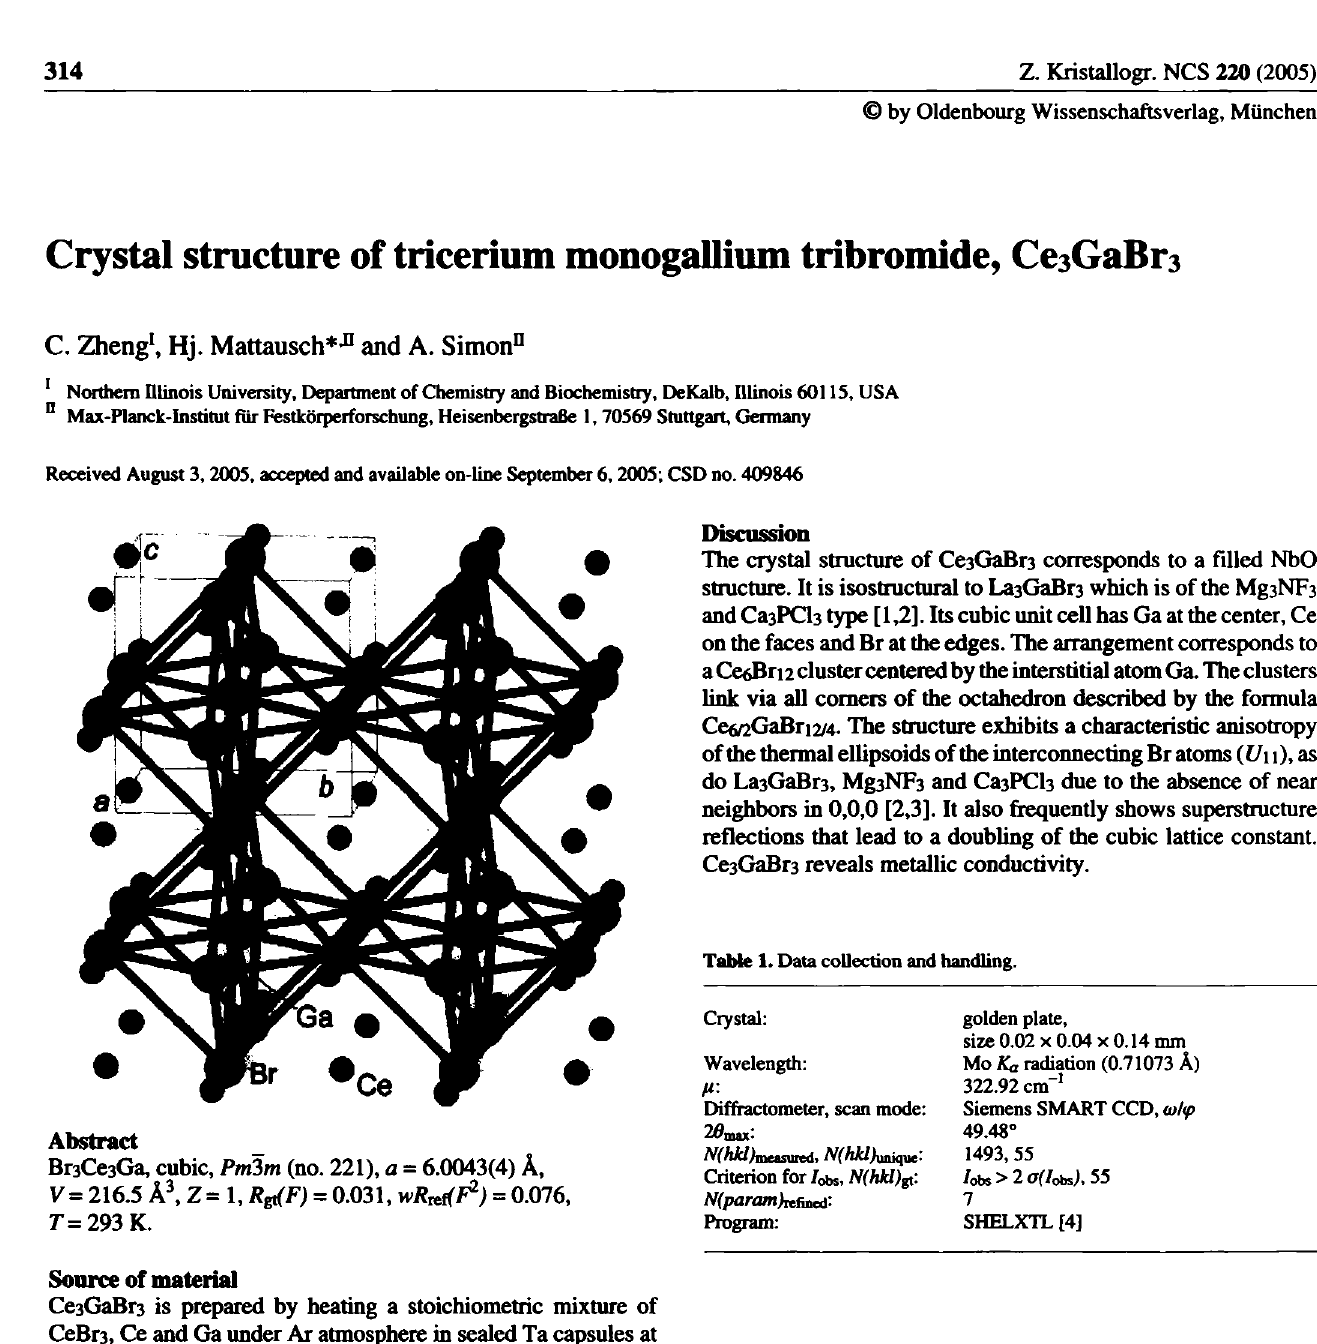
Table 2. Atomic coordinates and displacement parameters (in Ä 2 ).